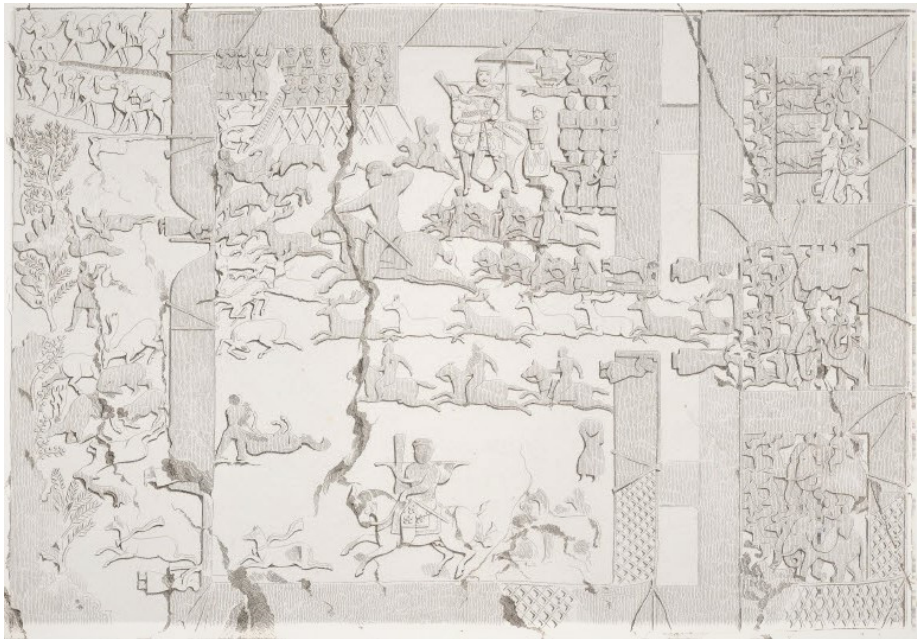
Figure 5. Deer hunt relief, rock relief, end of the 6th century CE, Taq ‐ e Bustan, The Great Grotto. Source: Flandin, E.; Coste, P. Voyage en Perse, Gide et J. Baudry, Paris, France 1851.